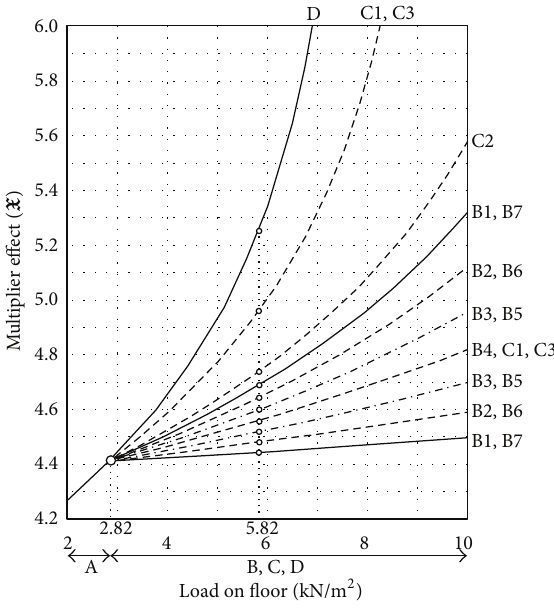
Figure 5: Multiplier ( X ). 𝐿 = 12 m. 𝐻 = 𝐿/33 . 𝛼 0 = 26.57 ∘ .